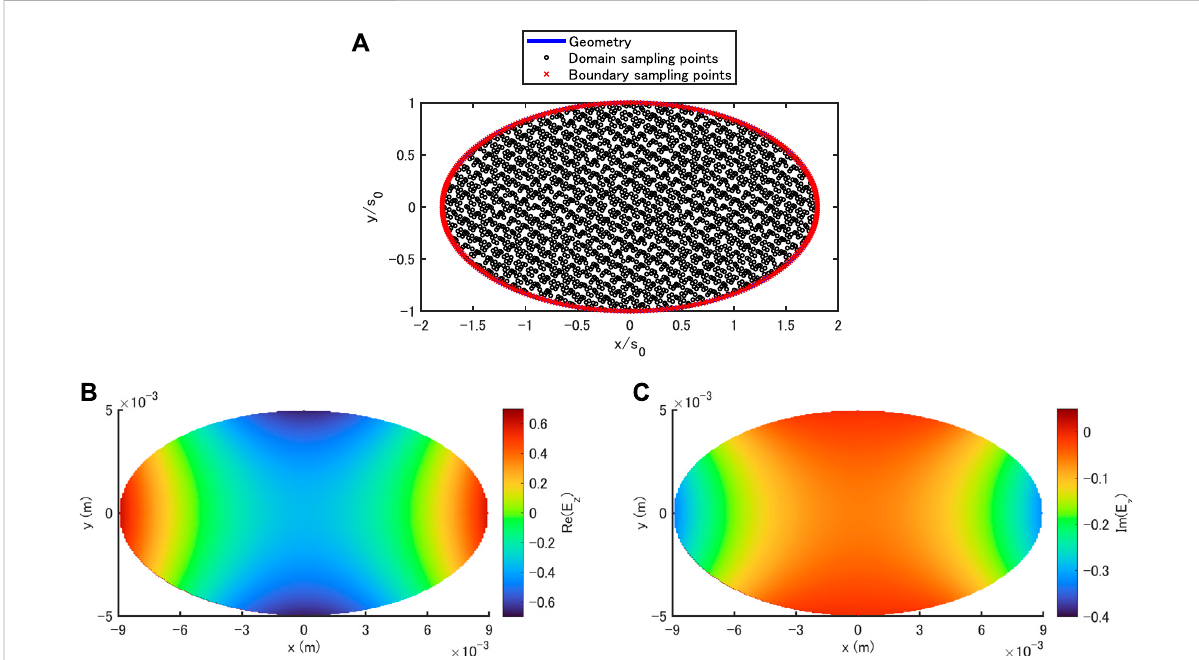
FIGURE 8 PINN-simulated fi eld distribution E z over a domain surrounded by the innermost wall of a three-layer elliptical vacuum chamber (A) sampling points (B) real part (C) imaginary part.